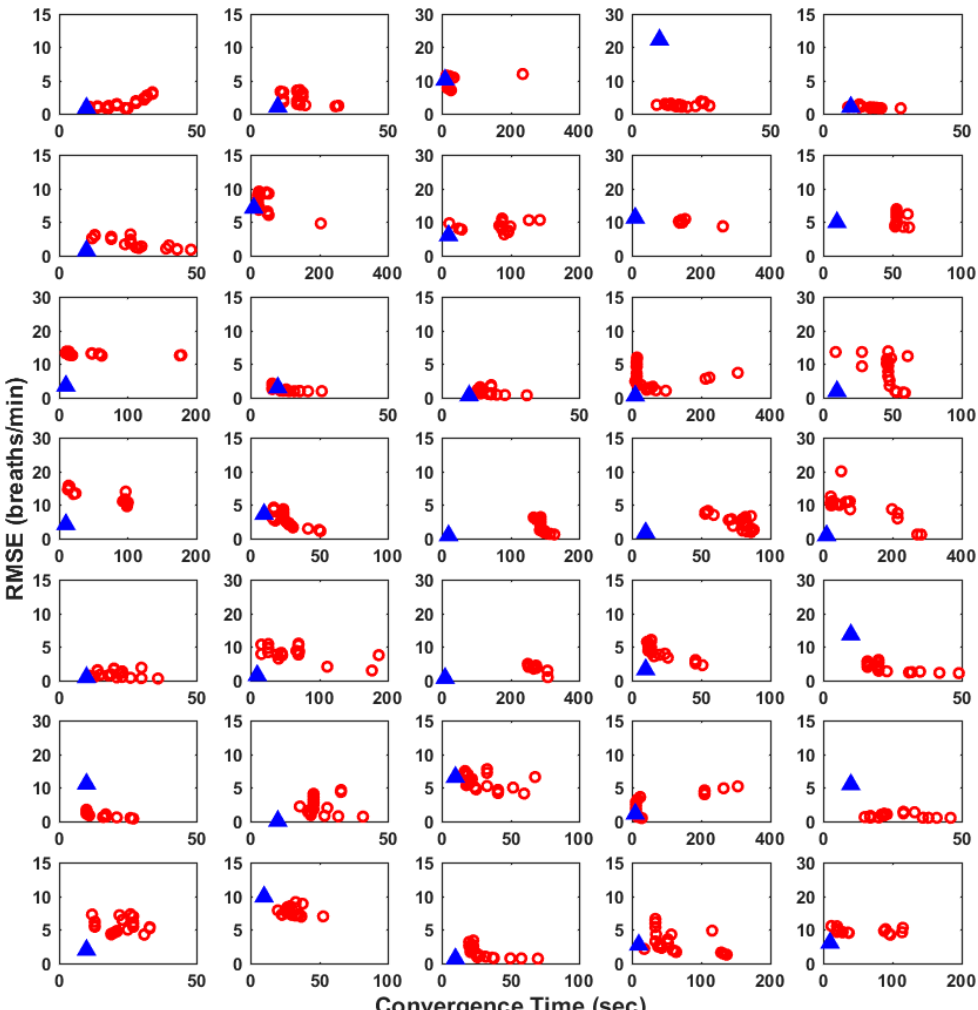
Figure 4. Scatter plots comparing root mean square errors (RMSEs) and convergence times (CTs) of the proposed method and adaptive lattice-type respiratory rate estimator (ALRE) in 35 PPG data. The solid blue triangle represents the RMSE and the time necessary for the initialization of the proposed method, while the hollow red circles represent 21 RMSEs and CTs of ALRE. Black arrows are marked only when the performance of ALRE was better than that of the proposed method.